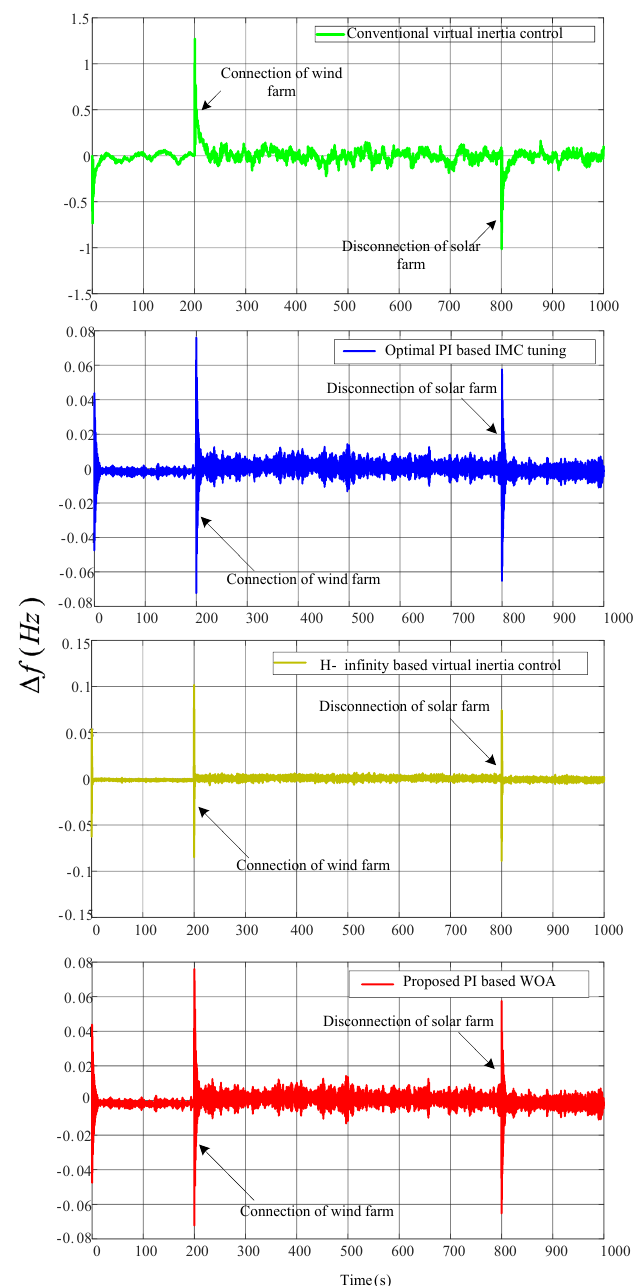
Figure 9. Frequency response under medium system inertia. The maximum overshoot and maximum undershoot of frequency deviation in the studied µG with the proposed coordination are about 0.07605 Hz and 0.07227 Hz, respectively. In the case of conventional virtual inertia control, optimal PI-based IMC and H ∞ -based virtual inertia control are 1.273 Hz and 1.014 Hz, 0.5694 Hz and 0.4718 Hz, and 0.1015 Hz and 0.0886 Hz, respectively.